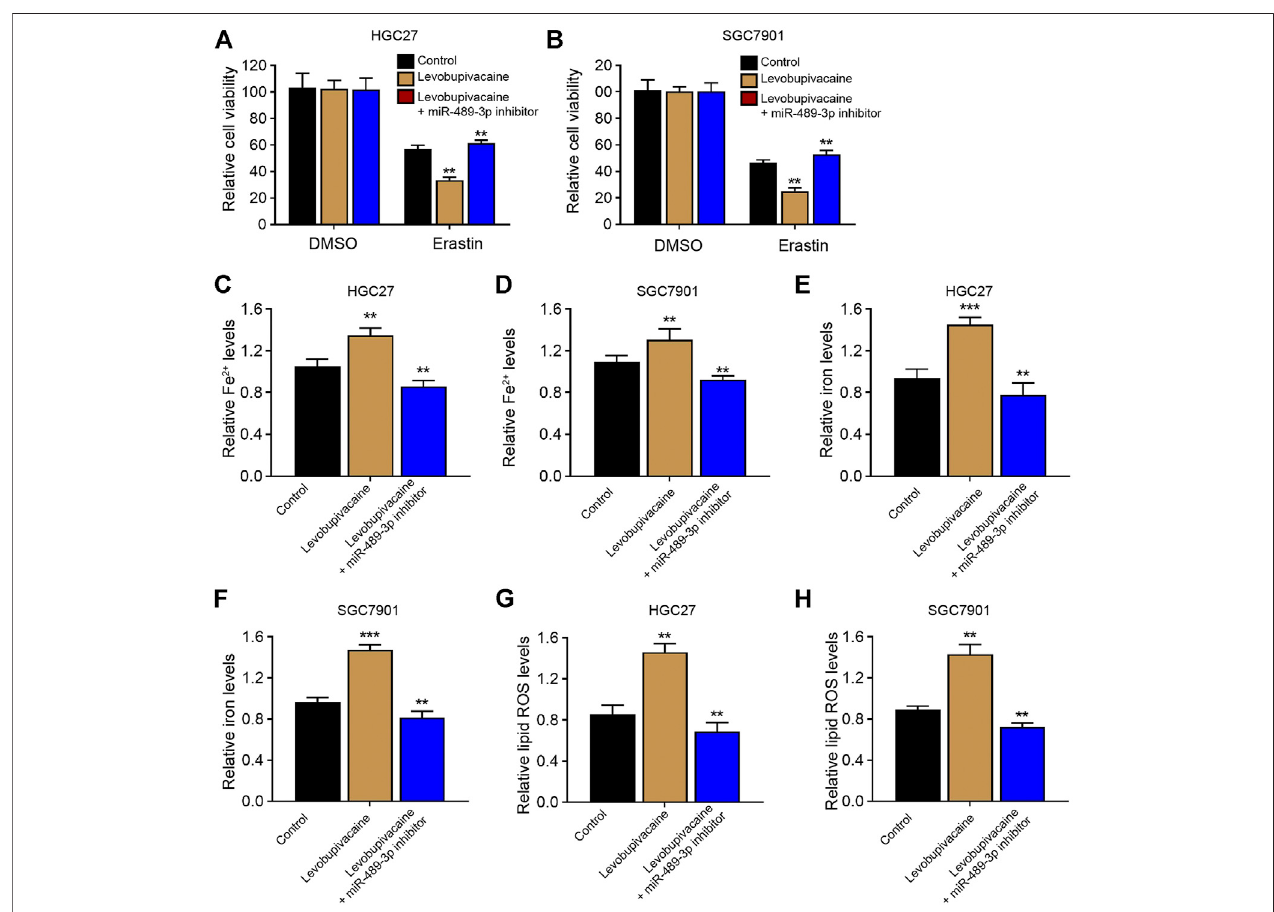
FIGURE 5 | MiR-489-3p is involved in levobupivacaine-induced ferroptosis of gastric cancer cells. (A – H) The erastin (5 μ M)-treated HGC27 and SGC7901 cells were co-treated with levobupivacaine and miR-489-3p inhibitor. (A,B) MTT assays for cell viability analysis. The Fe 2+ (C,D) , iron (E,F) , and ROS levels (G,H) were analyzed. The experiments were performed independently three times (mean ± SD, ** p <